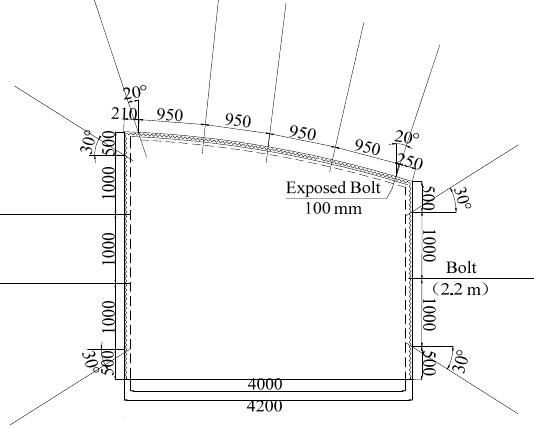
Figure 2. Schematic diagram of roadway support. The mining process of the coal working face uses a Φ 22 × 2400 mm HRB 600 resin anchored anchor bolt + diamond mesh + W steel belt + tray support. The anchor bolt anchorage length was 1.2 m. The three middle rows of anchor bolts were installed on the vertical roof (at an angle of 14 ◦ with the vertical line), and the outermost anchor bolts were installed at an angle of 20 ◦ with the vertical